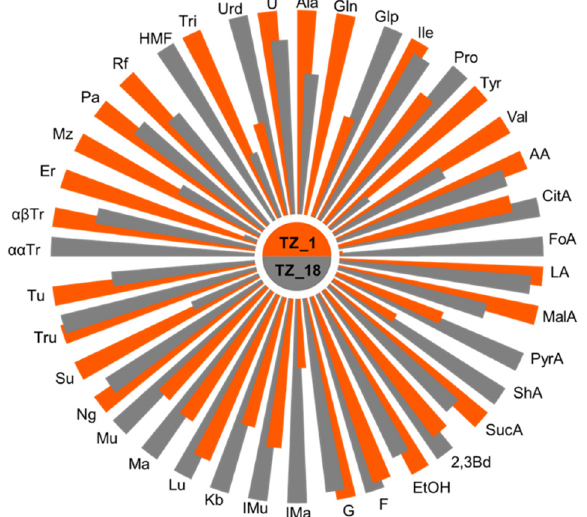
Figure 5. Nightingale’s diagrams illustrating the change in the quantities of the components studied in M. ferruginea honey after 18 months (TZ_1 vs. TZ_18). Acronyms according to Figure 1. Interestingly, the stored pot-honey had higher concentrations of fructose, probably due to degradation of some fructose-containing di- and trisaccharides, while in most European honeys, monosaccharides were converted into disaccharides after storage [32]. Other changes in the carbohydrate profile can be observed in Figure 5. Detected was an increase in the quantity of pyroglutamic acid (from 0.13 g to 0.22 g/100 g), probably due to microbiological activity and Maillard reactions [33]. The amount of other amino acids decreased over storage time, while proline increased, and isoleucine remained stable. Differences in organic acid contents between fresh and stored honey were visible (Figure 5 and Table S2), while small differences in the content of 2,3-butanediol and ethanol were also detected. As in A. mellifera honey, HMF concentration increased with time [34]. The difference between M. ferruginea and A. mellifera honey was also demonstrated by PCA and hierarchical cluster analysis based on the NMR quantification of honey constituents (Figure